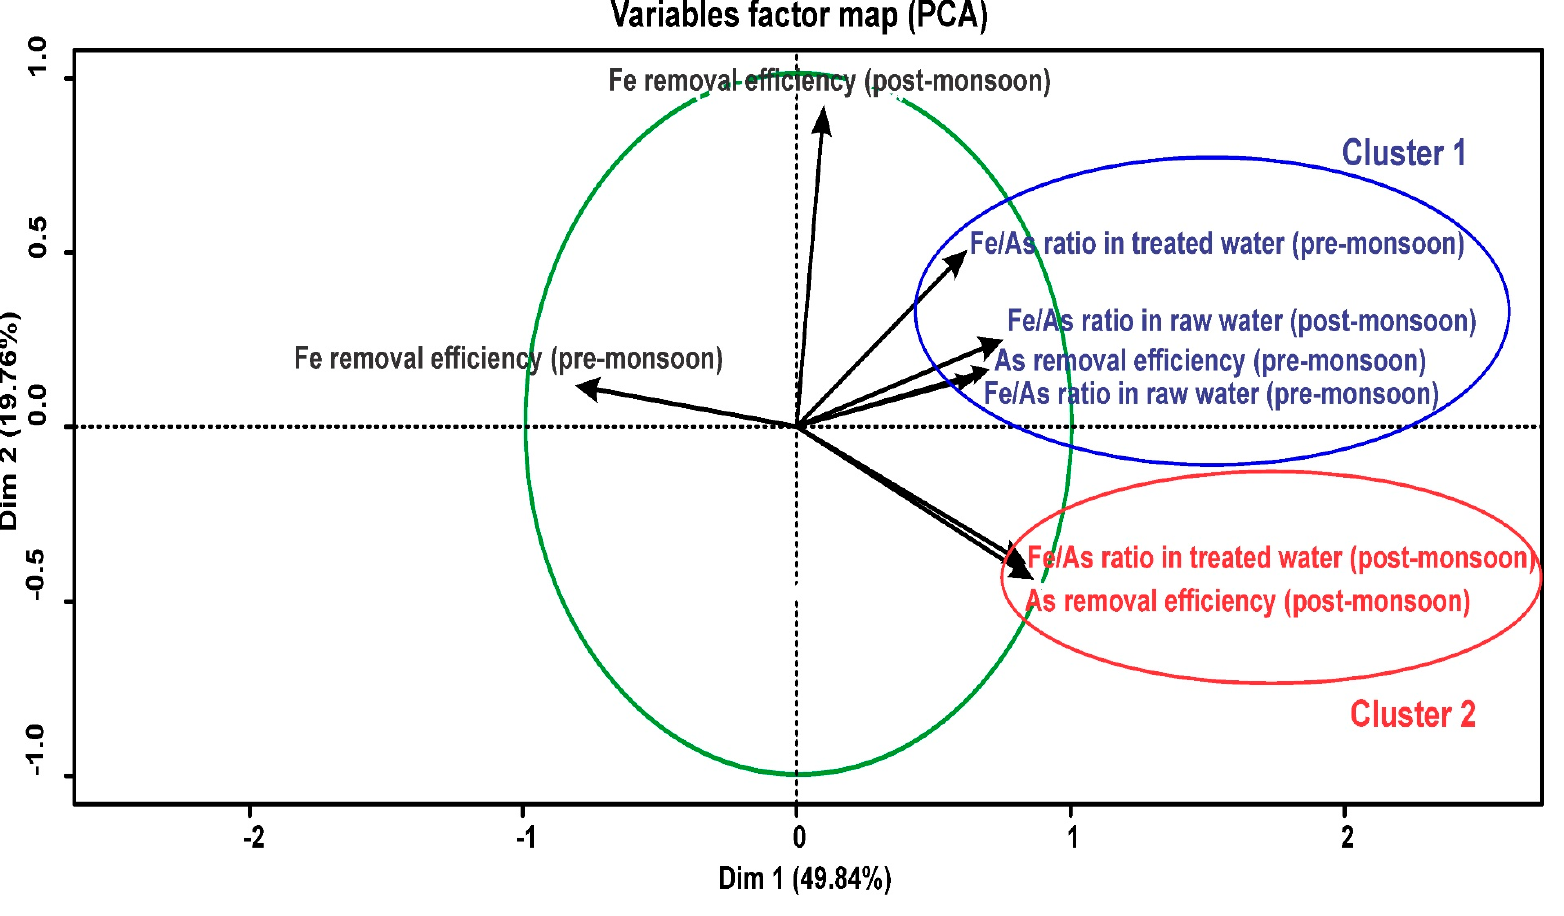
Figure 6. Component plot of principal component analysis.